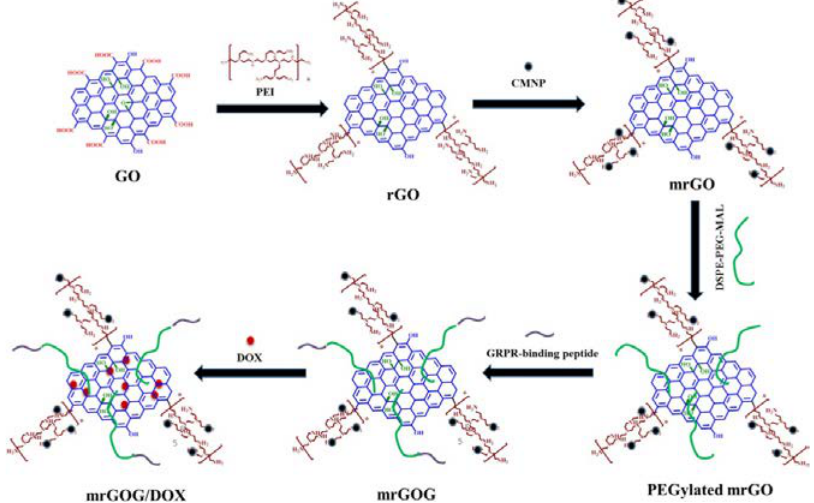
Figure 13. The process of preparing BBN-conjugated, DOX-loaded magnetic reduced graphene oxide NPs (mrGOG/DOX). Reprinted with permission from ref. [62]. Copyright 2022, Elsevier.